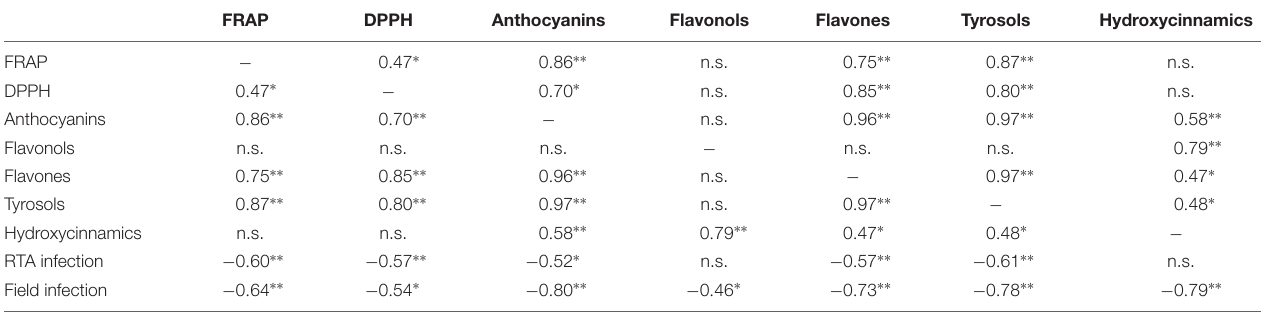
TABLE 7 | Two-tails Pearson correlation between in vitro antioxidant capacity assays and content of the main phenolic